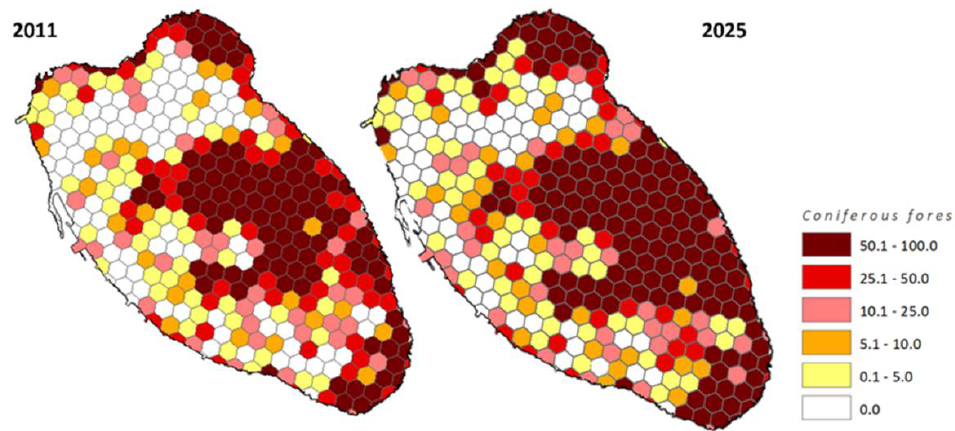
Figure 23. Results of simulation model of Aleppo pine expansion using